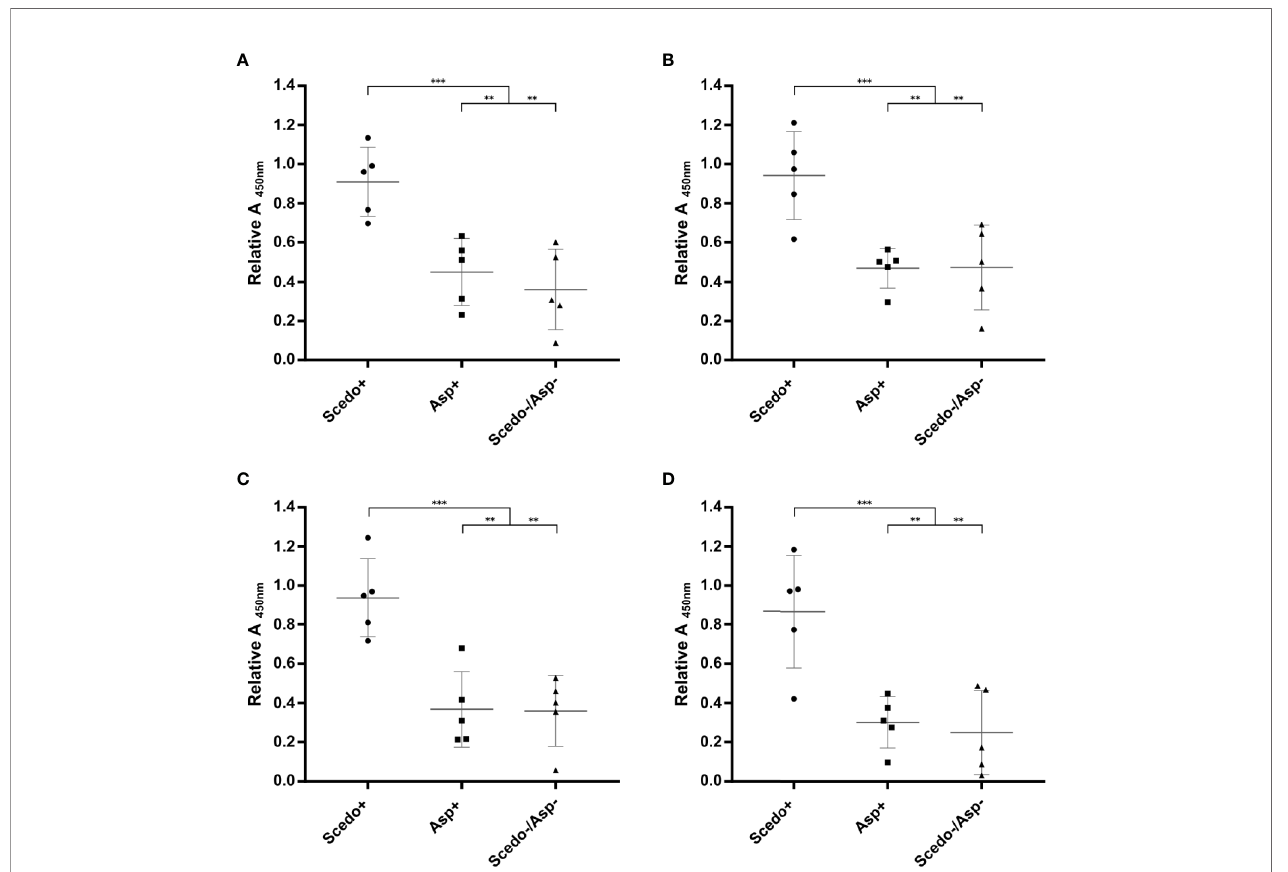
FIGURE 3 | Screening of the immunoreactivity of Cystic Fibrosis (CF) patients ’ sera against Scedosporium boydii protein extracts. Total WCP (A) , Secretome (B) , Total CSP (C), and Conidial CSP (D) . Speci fi c IgG antibody response is represented for the fi ve sera selected from each group (Scedo+, Asp+ and Scedo-/Asp-) and against each protein extract, by relative Abs value at 450 nm obtained for each serum. Wide horizontal lines depict the media, and short horizontal lines represent the standard deviation (SD). Median value obtained for group Scedo+ is signi fi cantly different from that obtained for each of the other two groups, and for the sum of both (as negative samples) (*** p < 0.001; ** p <